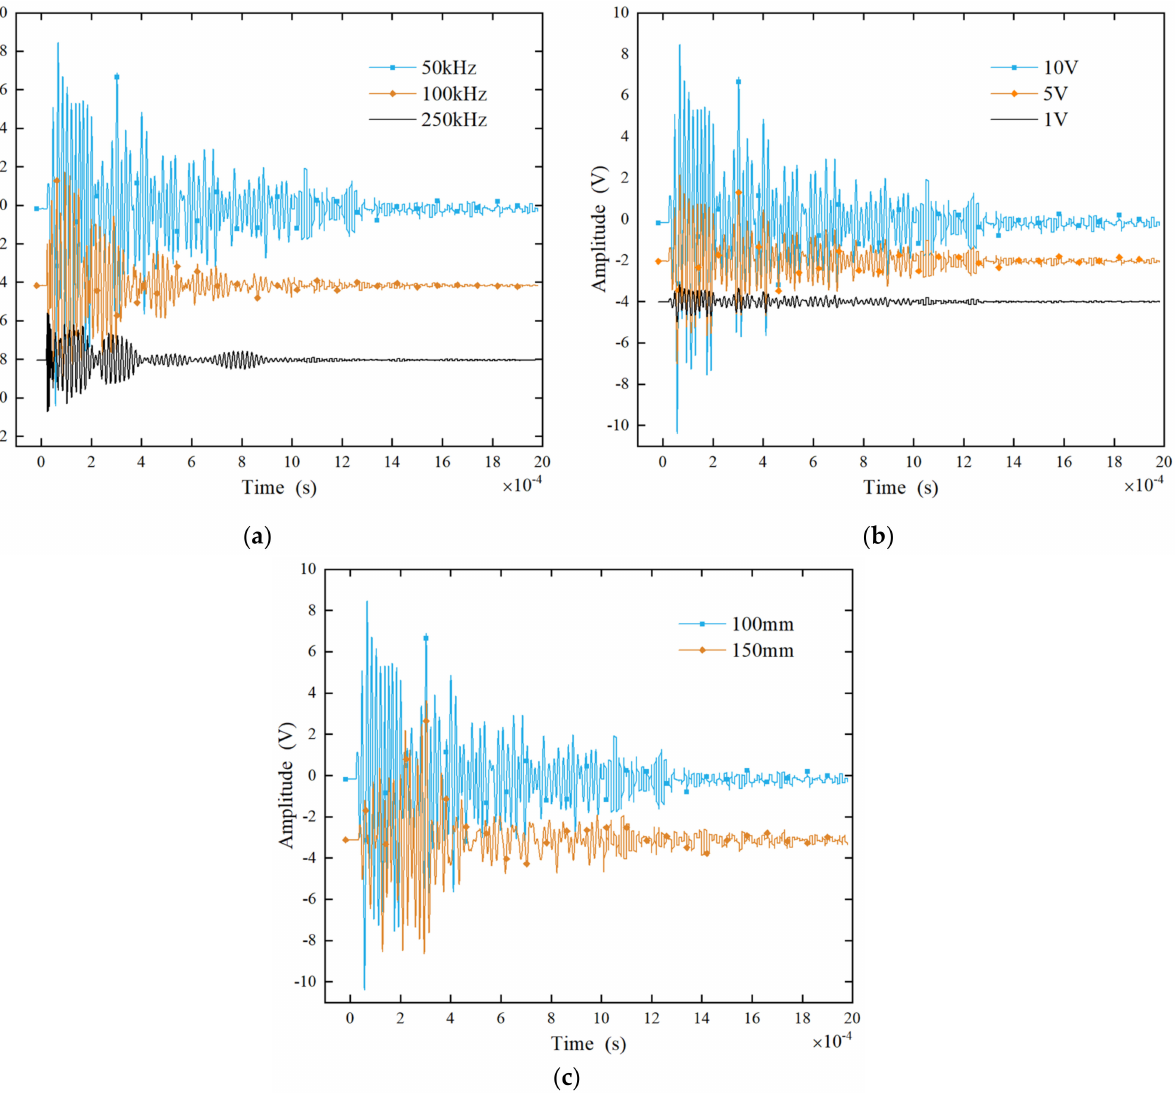
Figure 2. The original waveforms at the receiving end under different test parameters: ( a ) excitation frequencies; ( b ) excitation voltages; ( c ) test path